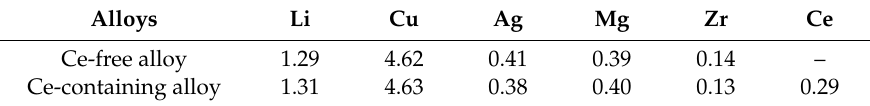
Table 1. Chemical composition of investigated alloys